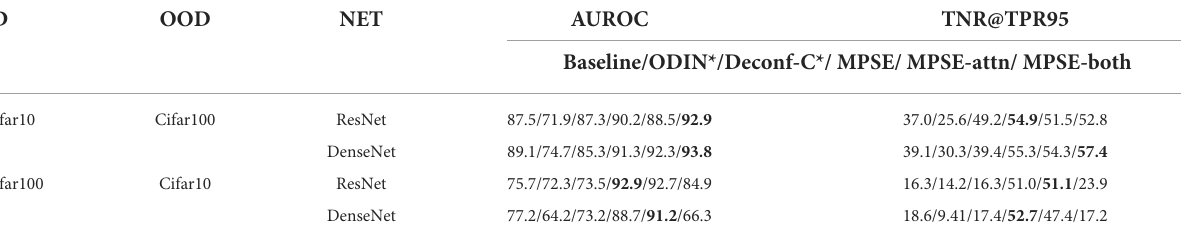
TABLE 6 Performance of different methods on SMOOD data with semantic extraction using ResNet as the bone network, best results are shown in bold.